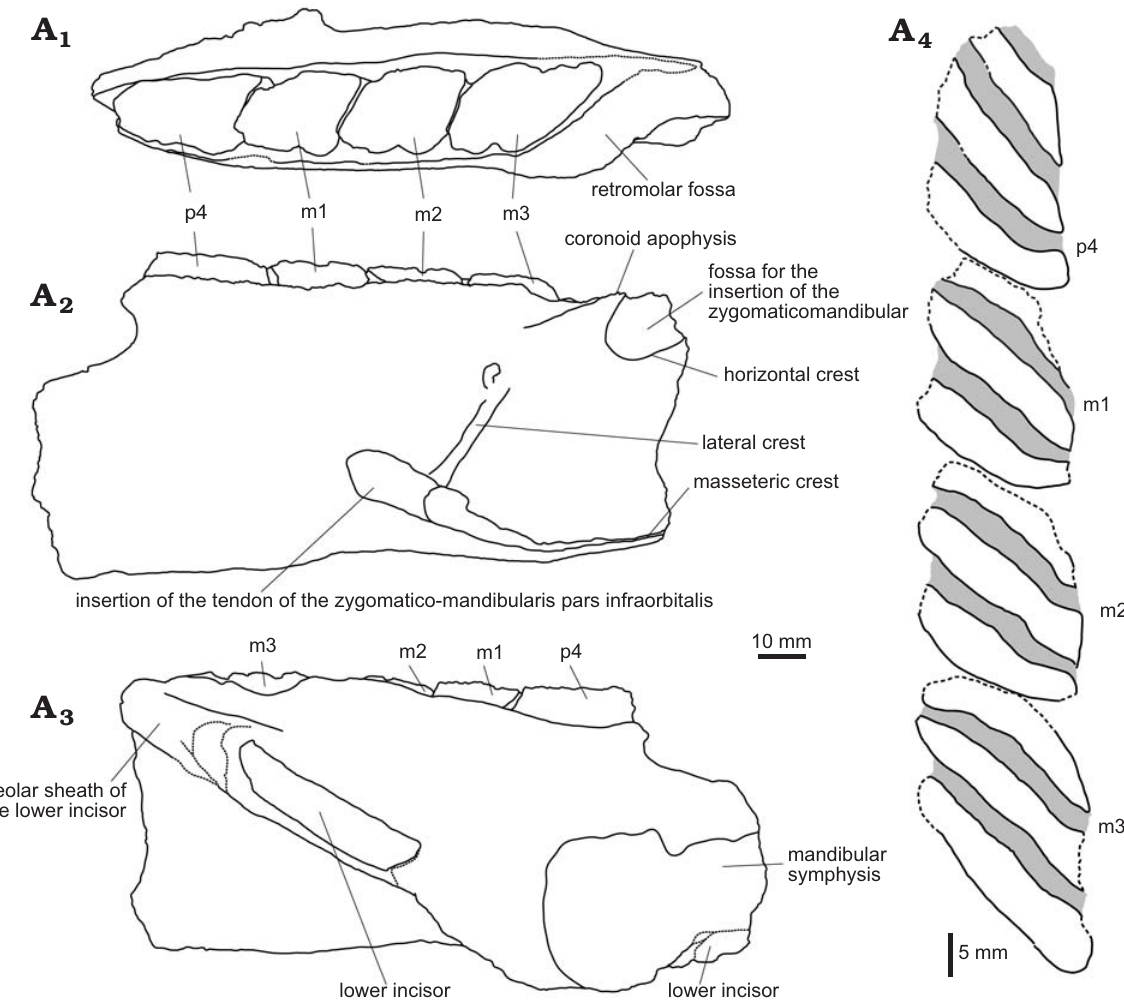
Fig. 3. Explanatory drawings of the MHNC-MS-001 attributed to caviomorph rodent Phoberomys sp., from Monte Salvado, Peruvian Amazonia, late Miocene or Pliocene; fragmentary left mandible in occlusal (A 1 ), labial (A 2 ), and lingual (A 3 ) views, p4–m3 in occlusal view (A 4 ). The dotted lines indi- cate incomplete